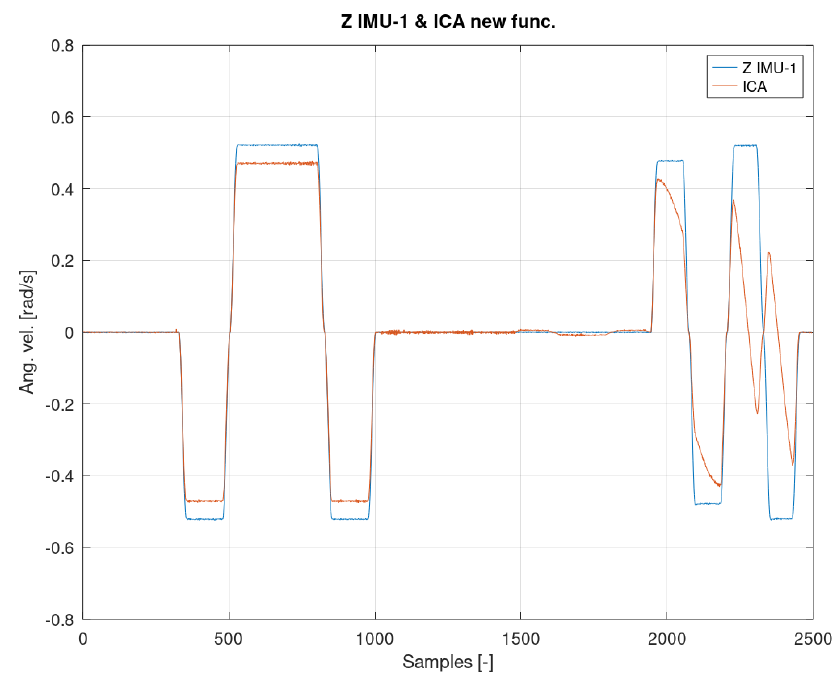
Figure 14. The result of the ICA algorithm on the basis of the activation Functions (17) and (18).